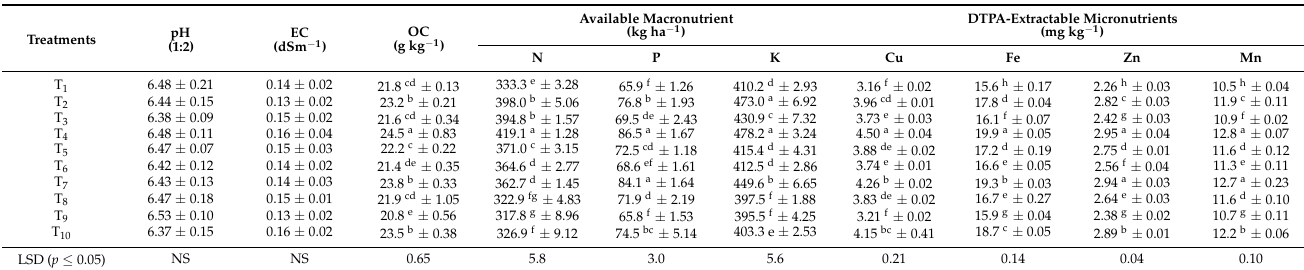
Table 5. Effects of panchagavya, jeevamrut, and organic manures on physicochemical properties and nutrient contents in the